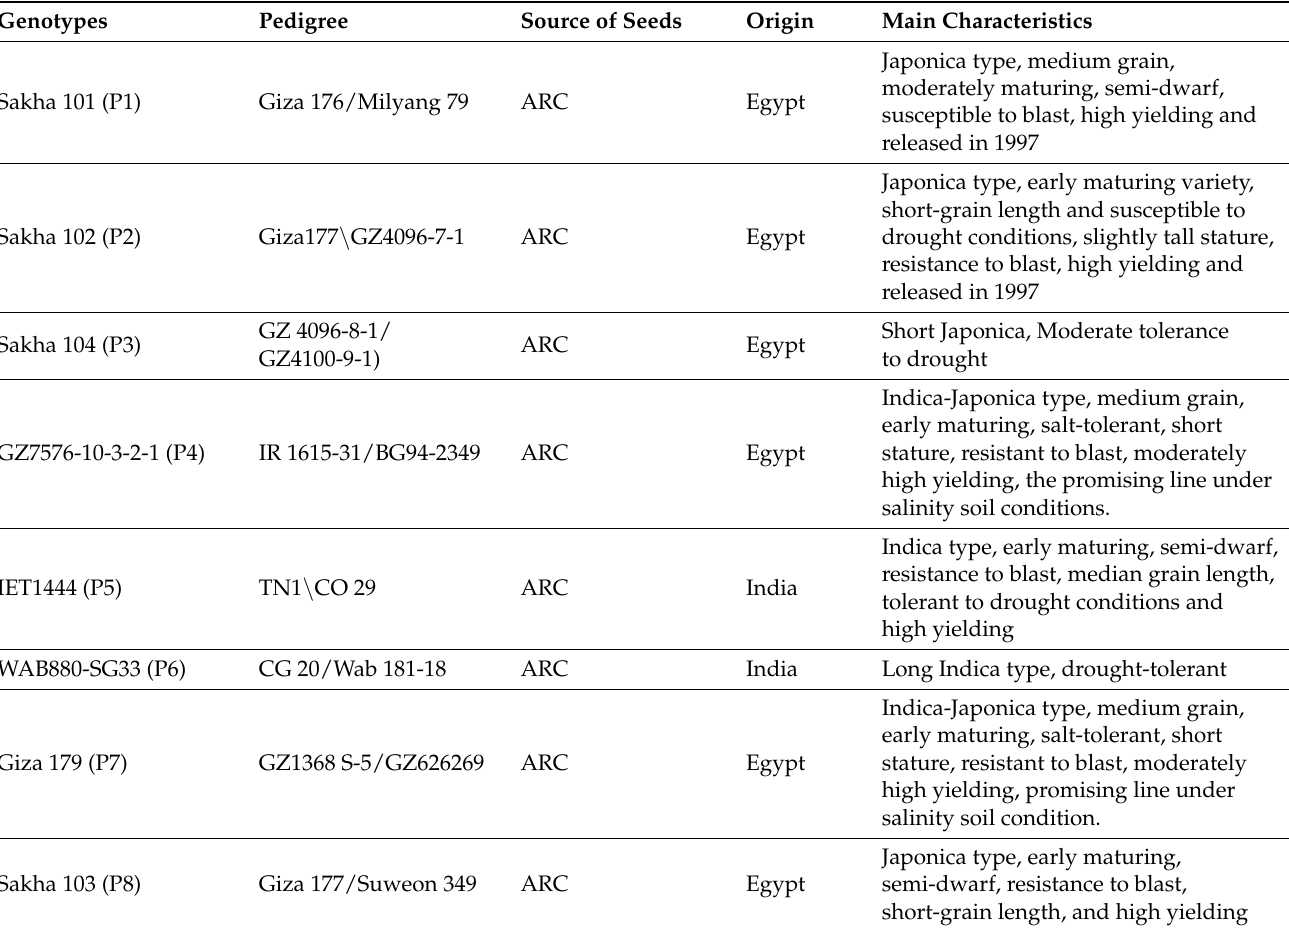
Table 5. Name, pedigree, origin, group type and main characteristics of the eight rice parent